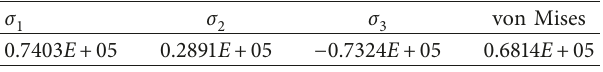
Table 9: The maximum principal stress and maximum von Mises stress of the bottom beam and bracket component (Pa).